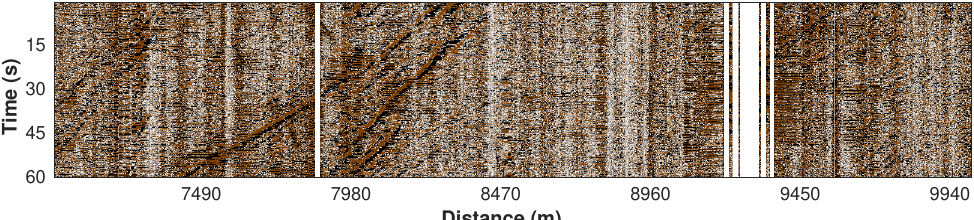
Figure 9. Amplitude scaling result. Data point with absolute value greater than threshold value is set to 0.01 or − 0.01 (according to its sign).